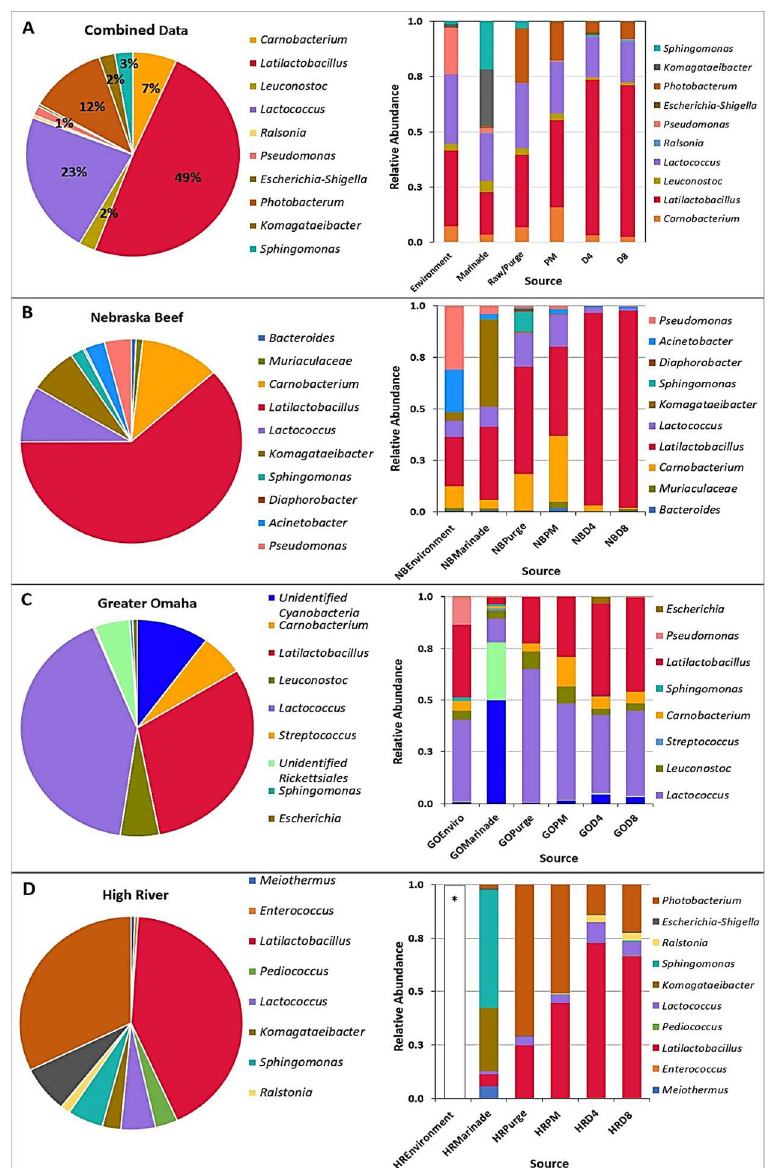
Figure 7. Relative abundance of total identified DNA from across all processing time points and the relation of OTUs to specific sampling sites for ( A ) combined sources, ( B ) Nebraska Beef, ( C ) Greater Omaha and ( D ) High River-JBS. OTUs were based on abundance with non-bacterial (mitochondrial and chloroplast) data removed. Relative abundance of organisms among specific process sampling points included Enviro/environmental samples; PM, post-marinade beef; D4, beef dried four days; D8, beef dried eight days. * Insufficient DNA was recovered for subsequent sequencing.